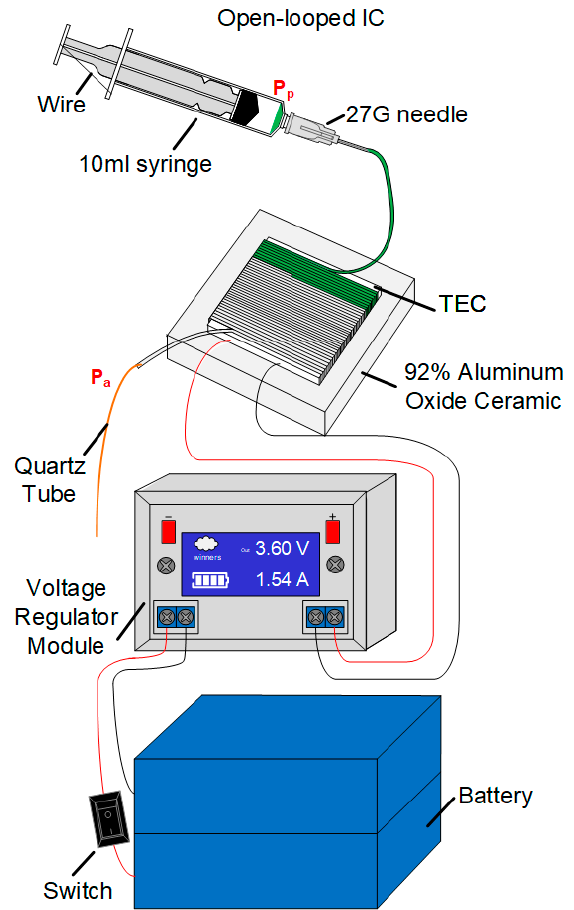
Figure 3. The assembly of the microdevice.